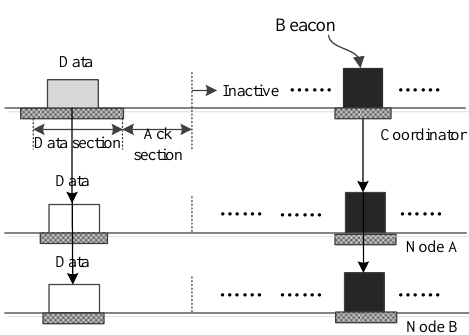
Figure 7. The coordinator broadcasts small data to all nodes.